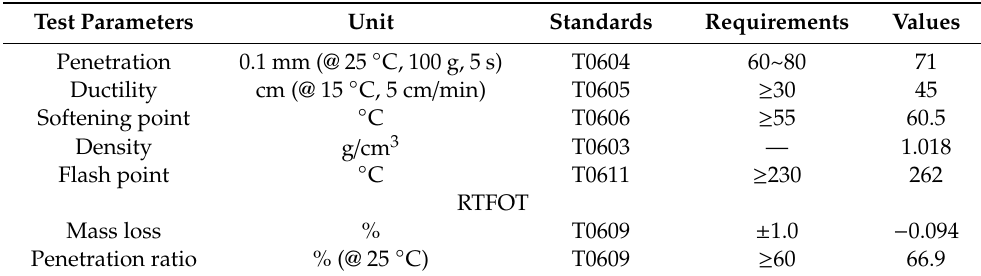
Table 1. Technical parameters of styrene-butadiene-styrene (SBS) modified asphalt.